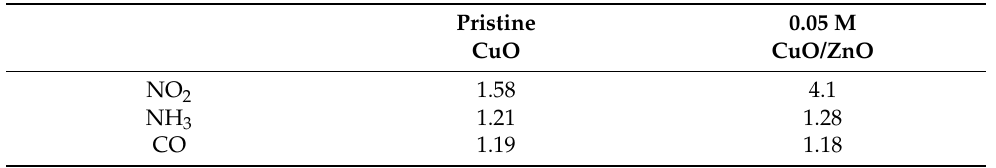
Table 3. Response of the pristine CuO and 0.05 M CuO/ZnO to 100 ppm NO 2 , NH 3 , and CO gas at 250 ◦